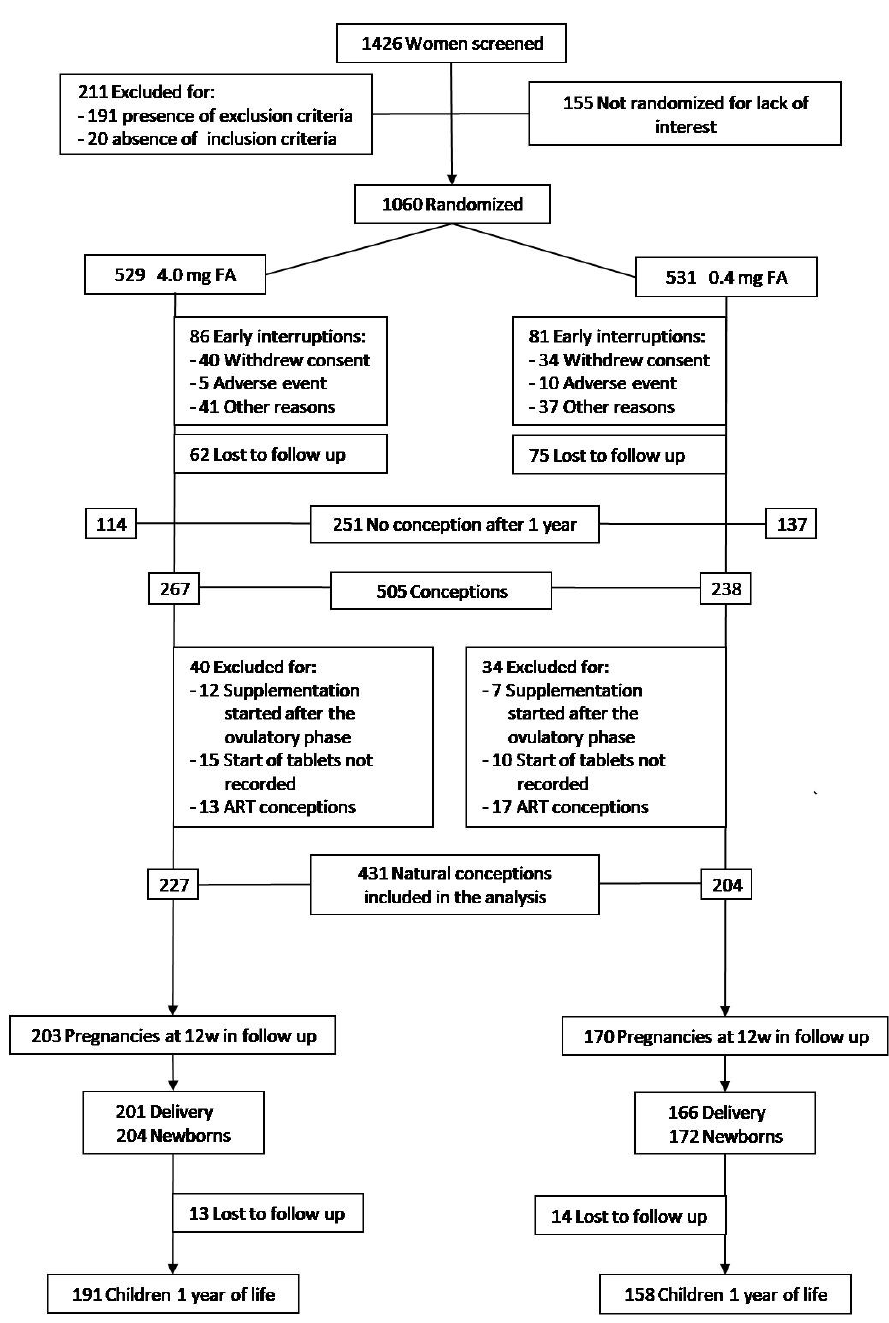
Figure 1. Enrolment, Randomization, and